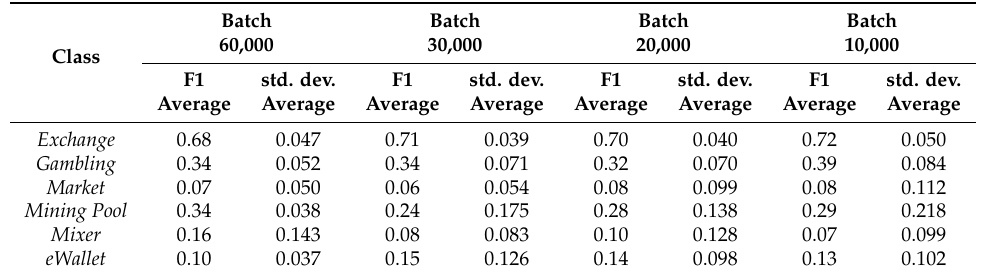
Table 3. F1-score average and standard deviation average computed with data from each